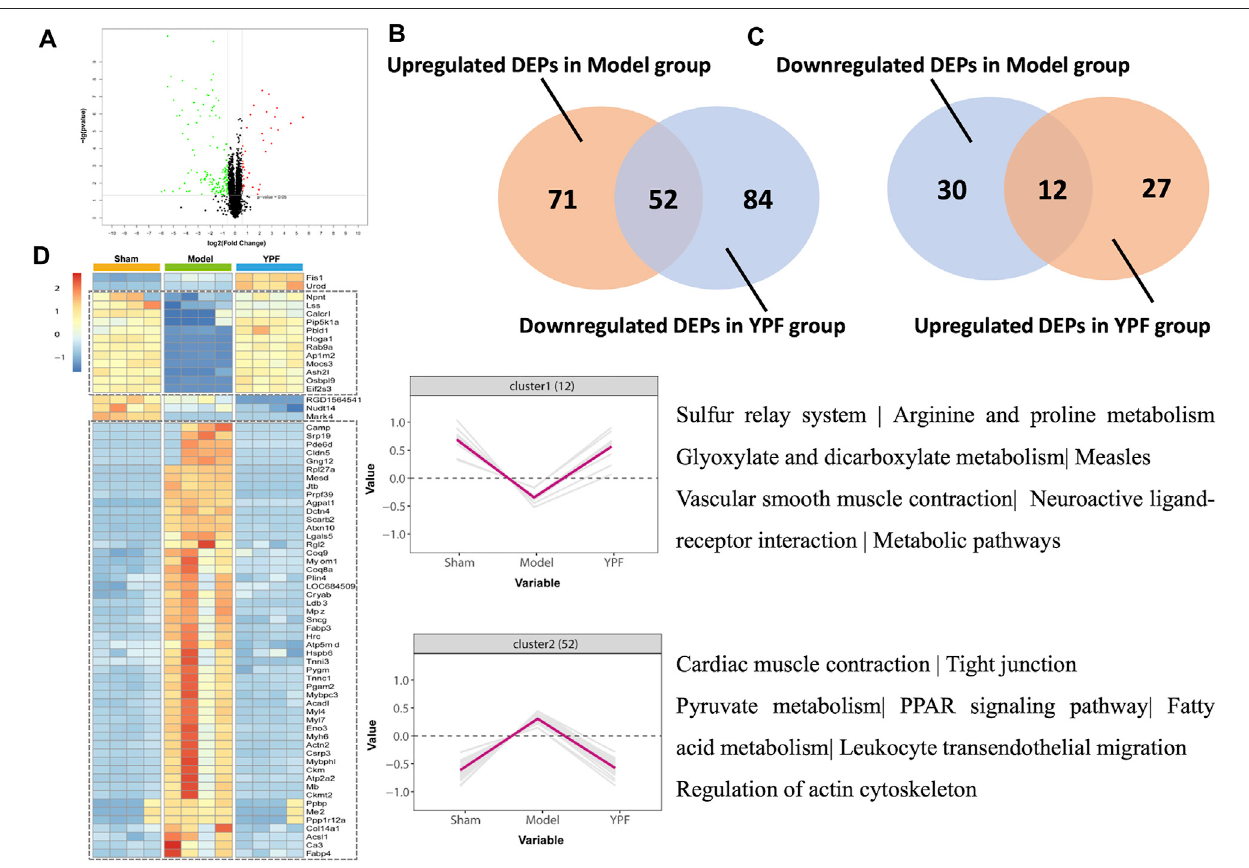
FIGURE 5 | Quantitative proteomic study on rat lung tissue. (A) Volcano plot of differentially expressed proteins (DEPs) identi fi ed between the exhausted-exercise group and the exhausted-exercise + YPF group. Red dots: represent upregulated DEPs; green dots: represent downregulated DEPs; and black dots: represent unchanged proteins. (B) Venn diagram of signi fi cantly changed proteins in upregulated DEPs of the exhausted-exercise group and downregulated DEPs of the exhausted-exercise group + YPF group with 52 proteins in intersection area. (C) Venn diagram of signi fi cantly changed proteins in downregulated DEPs of the exhausted-exercisegroupandupregulatedDEPsoftheexhausted-exercisegroup+YPFgroupwith12proteinsintheintersectionarea. (D) HeatmapofadjustingDEPs by YPF. The color bar represents the fold change from increasing to decreasing of all proteins identi fi ed in each group. Hierarchical clusters show a clear group differentiation according to similarity. Numbers of proteins and selected enriched KEGG pathways are indicated for marked